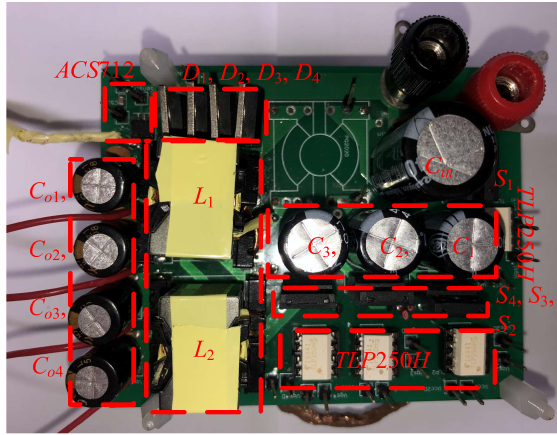
Figure 13. Photo of experimental setup.